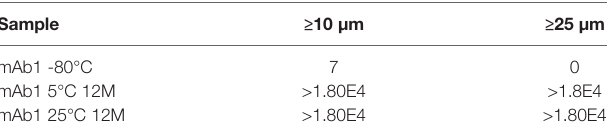
TABLE 3 | Light Obscuration